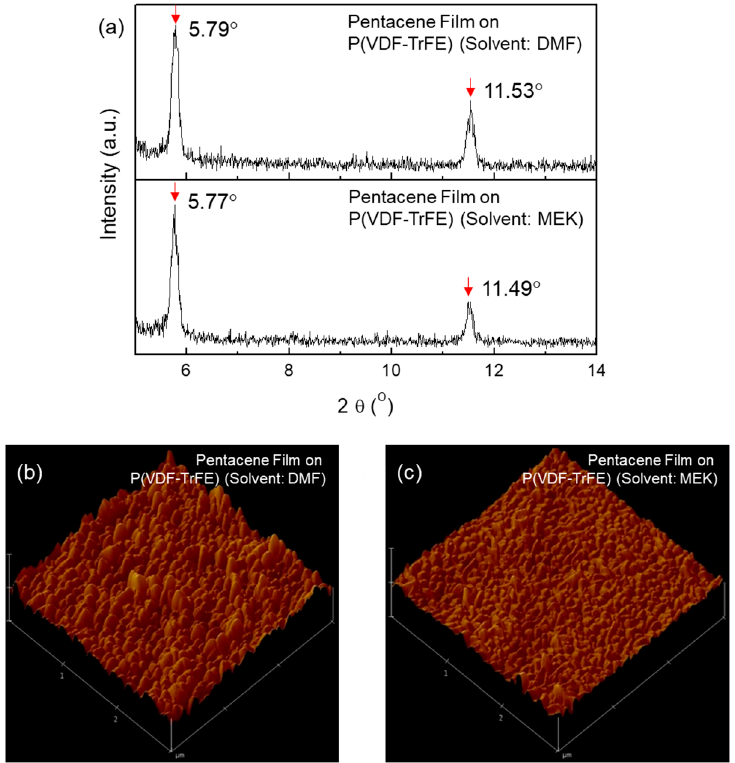
Figure 3. ( a ) XRD patterns of pentacene films on P(VDF-TrFE) from DMF (top) and MEK (bottom) solvents; AMF images of pentacene films on P(VDF-TrFE) from ( b ) DMF and ( c ) MEK